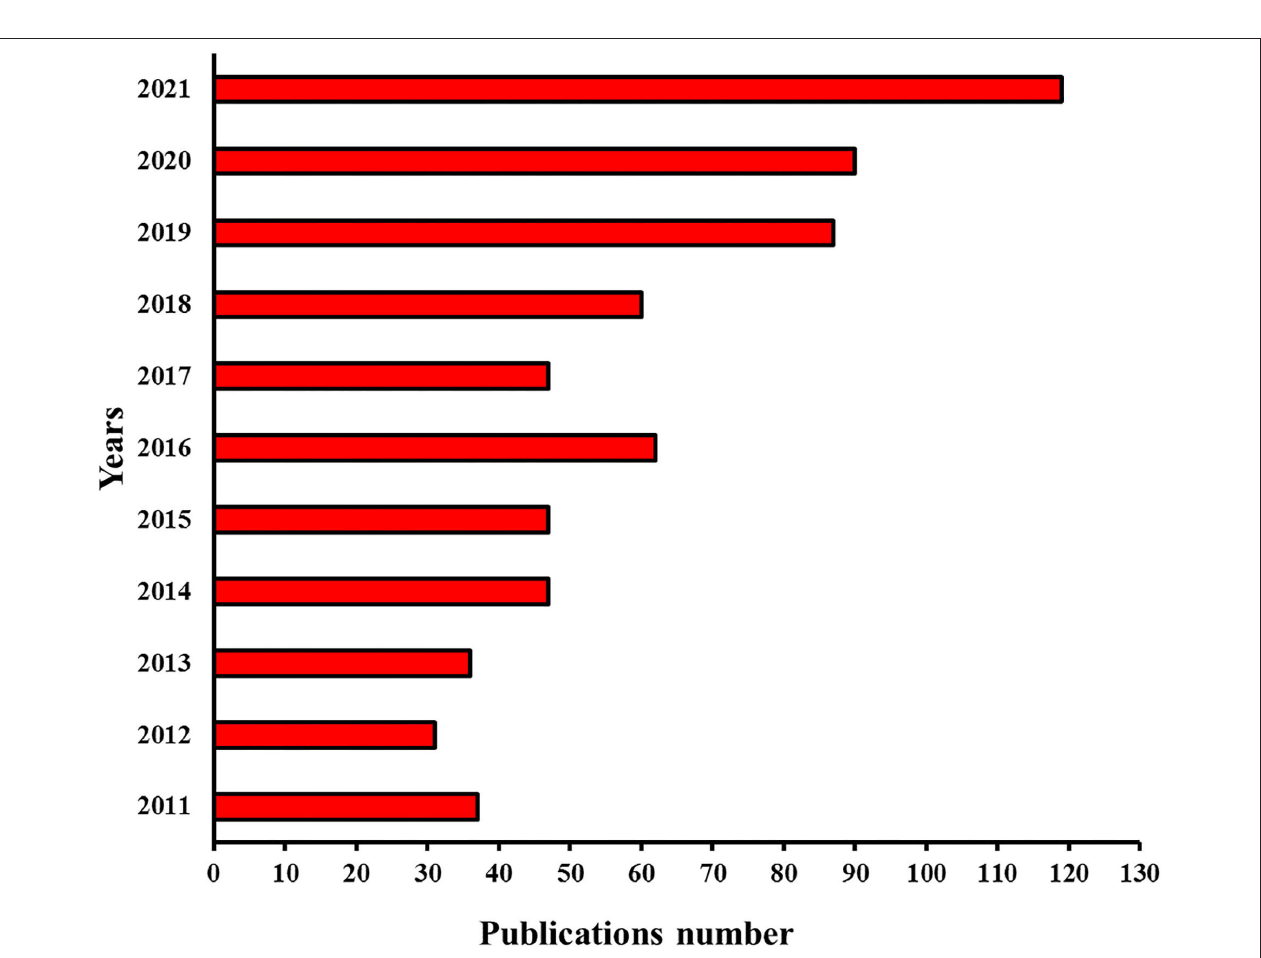
Frontiers in Nutrition |